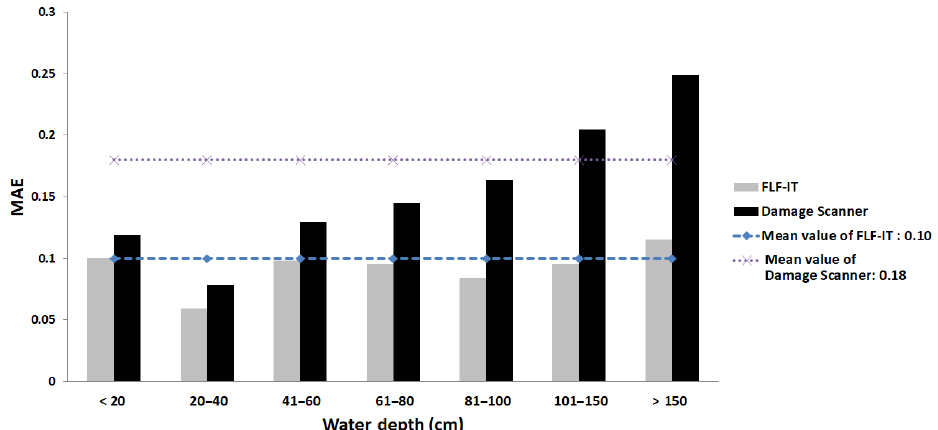
Figure 5. Comparison of the flood damage estimation models’ precision per water-depth class (MAE: mean absolute error; number of damage records for each sub-class of water depth, respectively, is 14, 36, 52, 96, 125, 222, and 68).